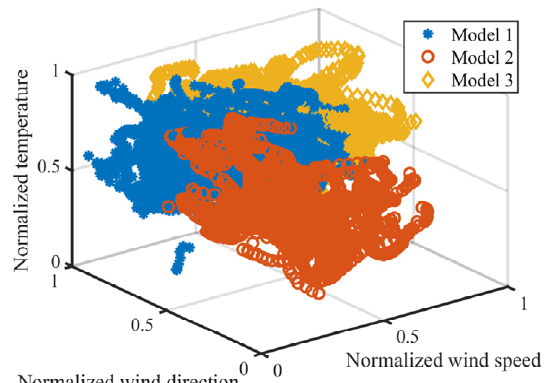
Figure 7. Clustering result of season 1.